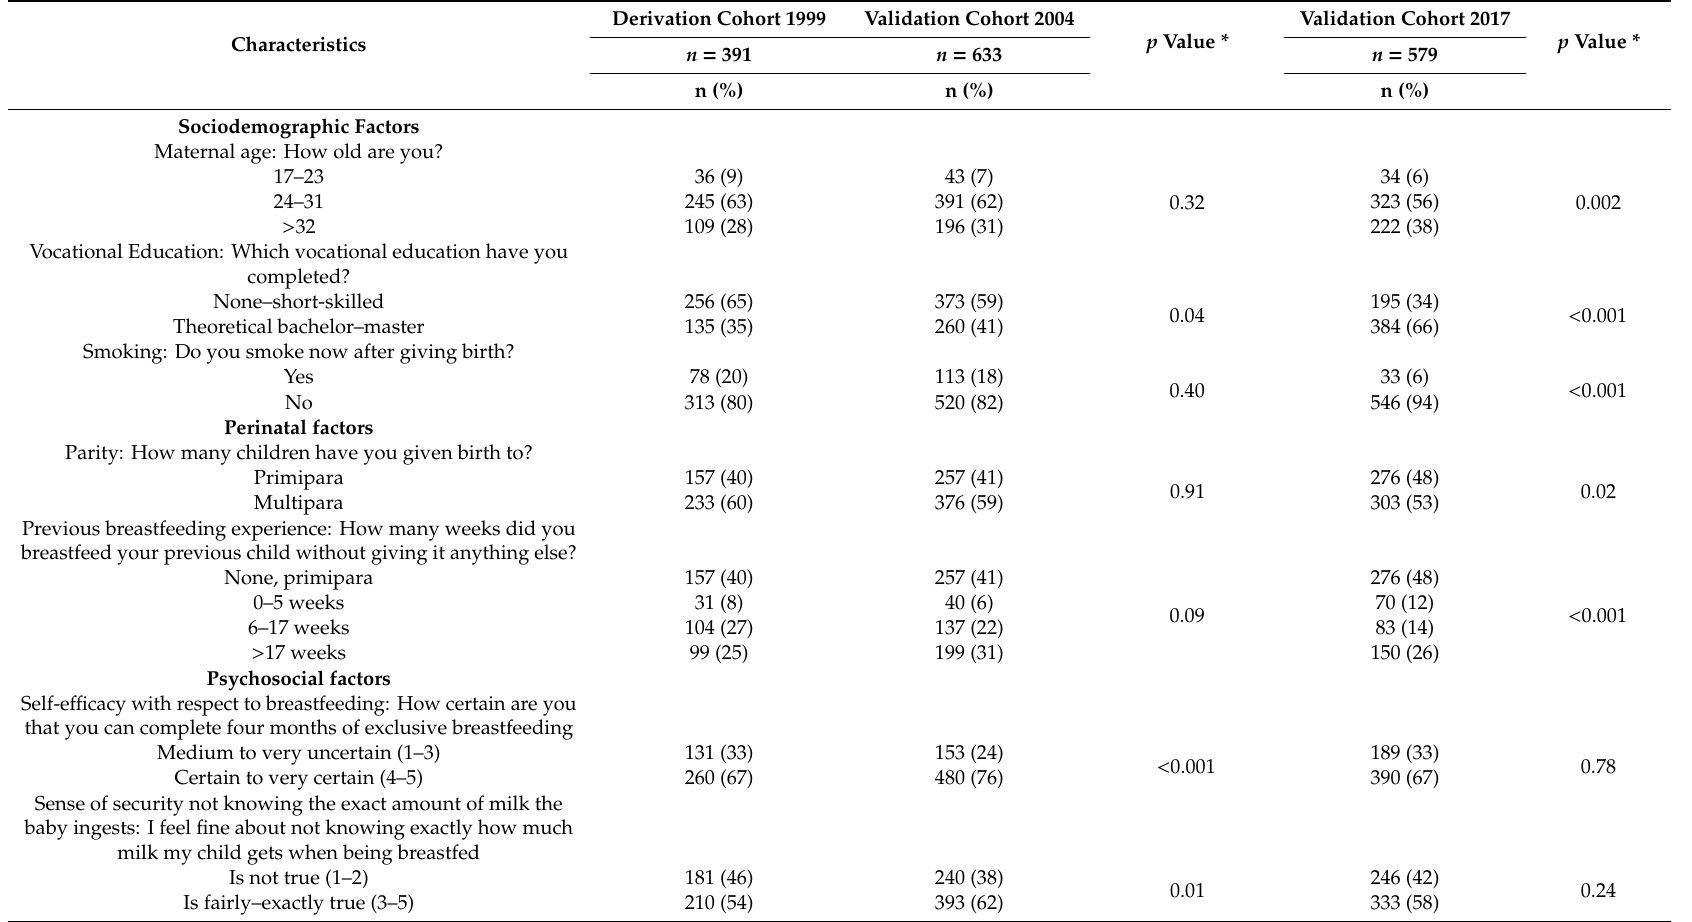
Table 1. Characteristics of mothers in the derivation and validation cohorts with complete information on the four questions included in the breastfeeding